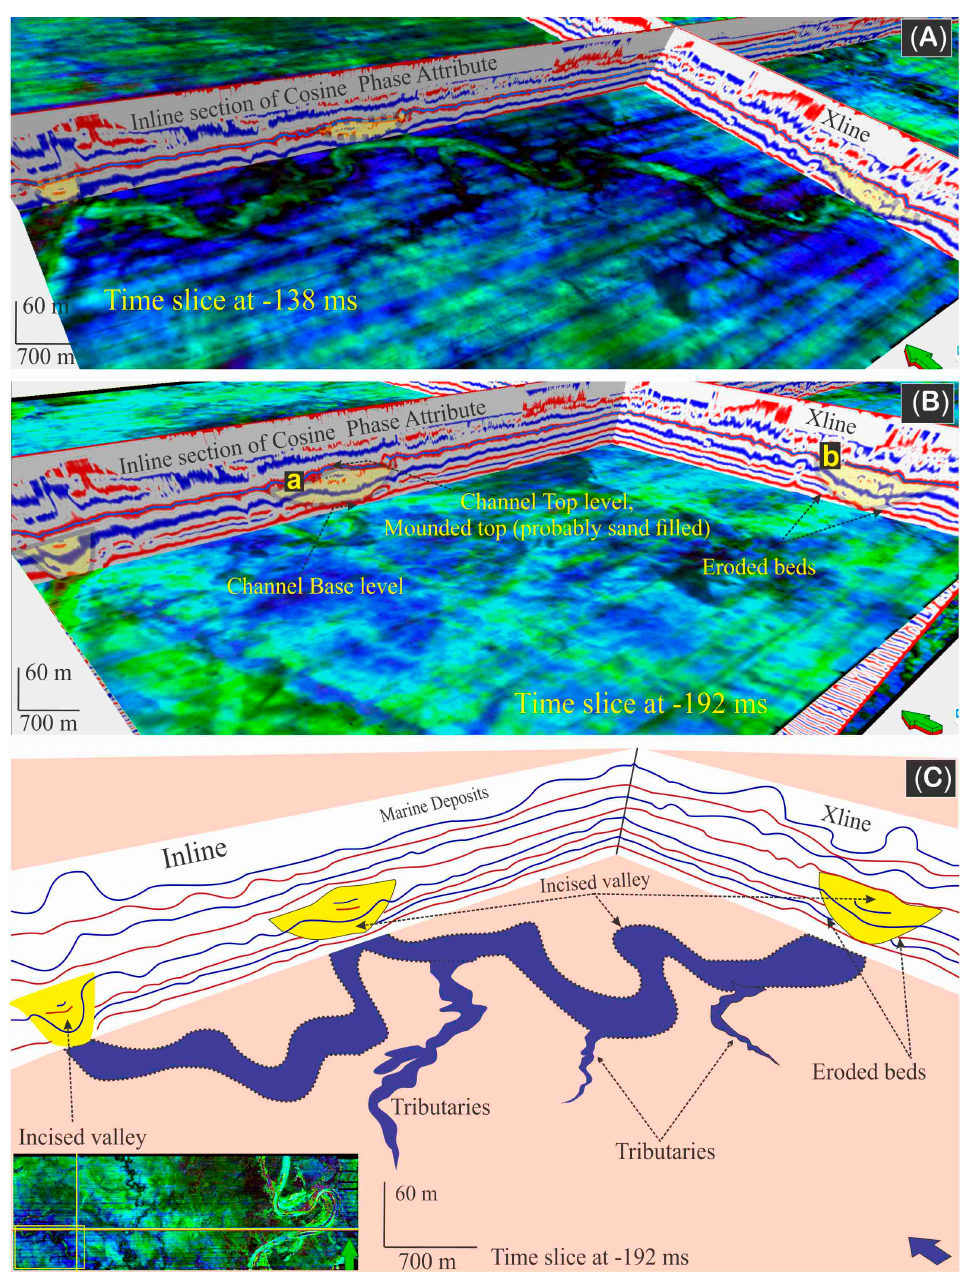
Figure 10. ( A ) Chair display zoomed-in map-view of the southwest fluvial meandered channel at approximately TWT − 138 ms with Xline and Inline Cosine of Phase seismic attribute across the sinuosity channel. The yellow colors represent the repeated channel in both Xline and Inline. ( B ) Another chair display for lower time slice with the same Xline and Inline Cosine of Phase seismic attribute, channel top-level showing a mounded top ( Ba ), which is probably filled with sand in the middle and clay in compressed ends. ( C ) The incised valley with its tributaries in blue color. The eroded beds formed reflector terminations down-laps against the incised valley walls.